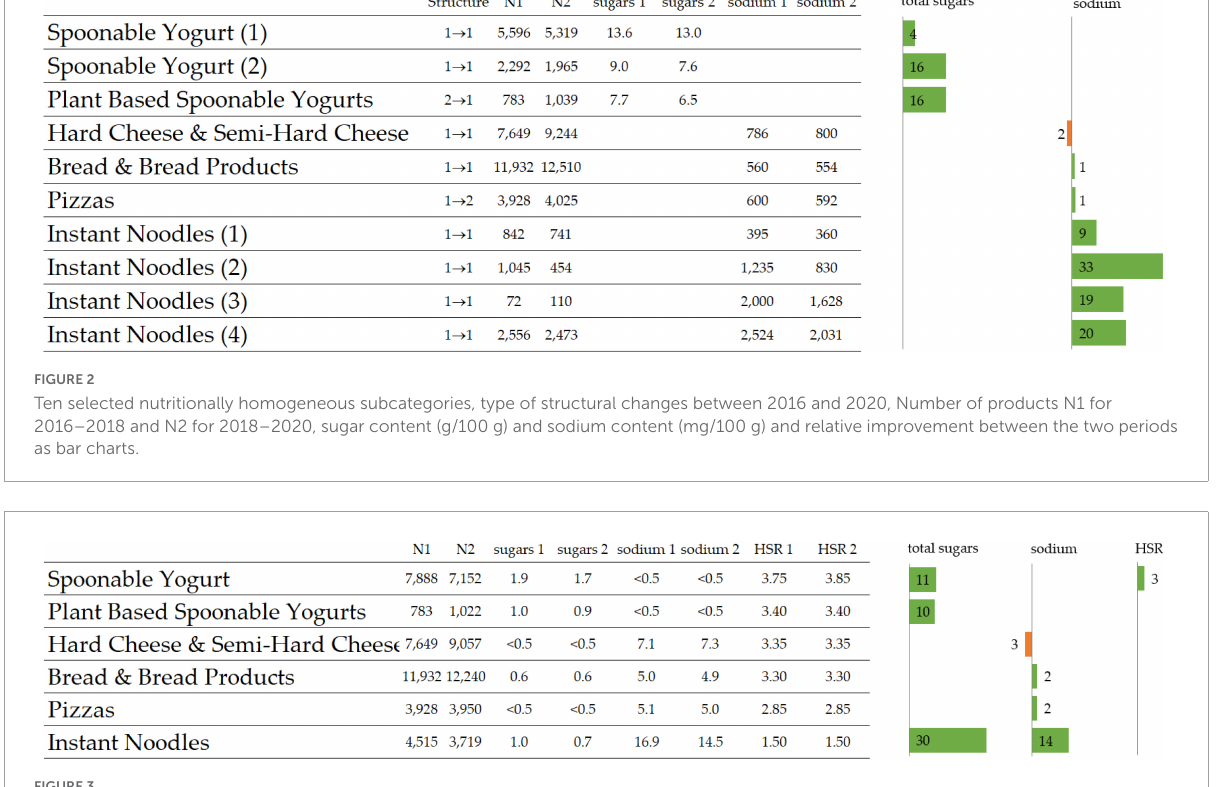
No significant evolution in structure or quality was observed for “Hard Cheese and Semi-Hard Cheese” and “Bread and Bread Products.” The single Pizzas category of 2016–2018 split into two subcategories in 2018–2020 ( Table 2 ). Indeed, the